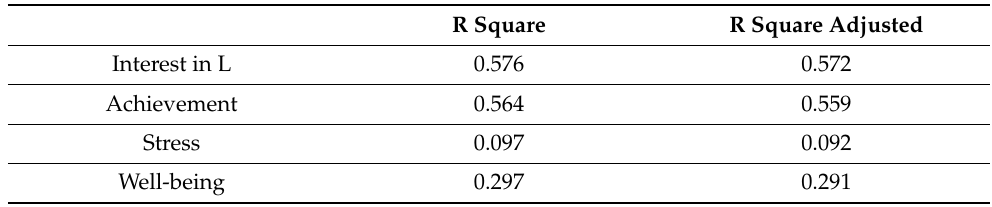
Table 6. Coefficient determination.